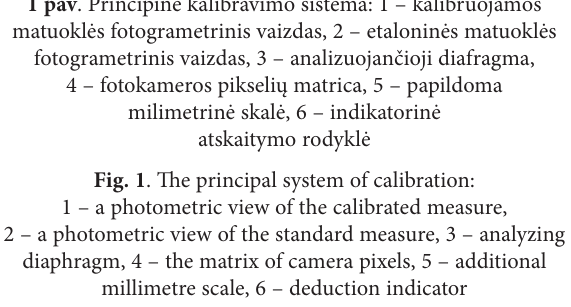
Fig. 1 . The principal system of